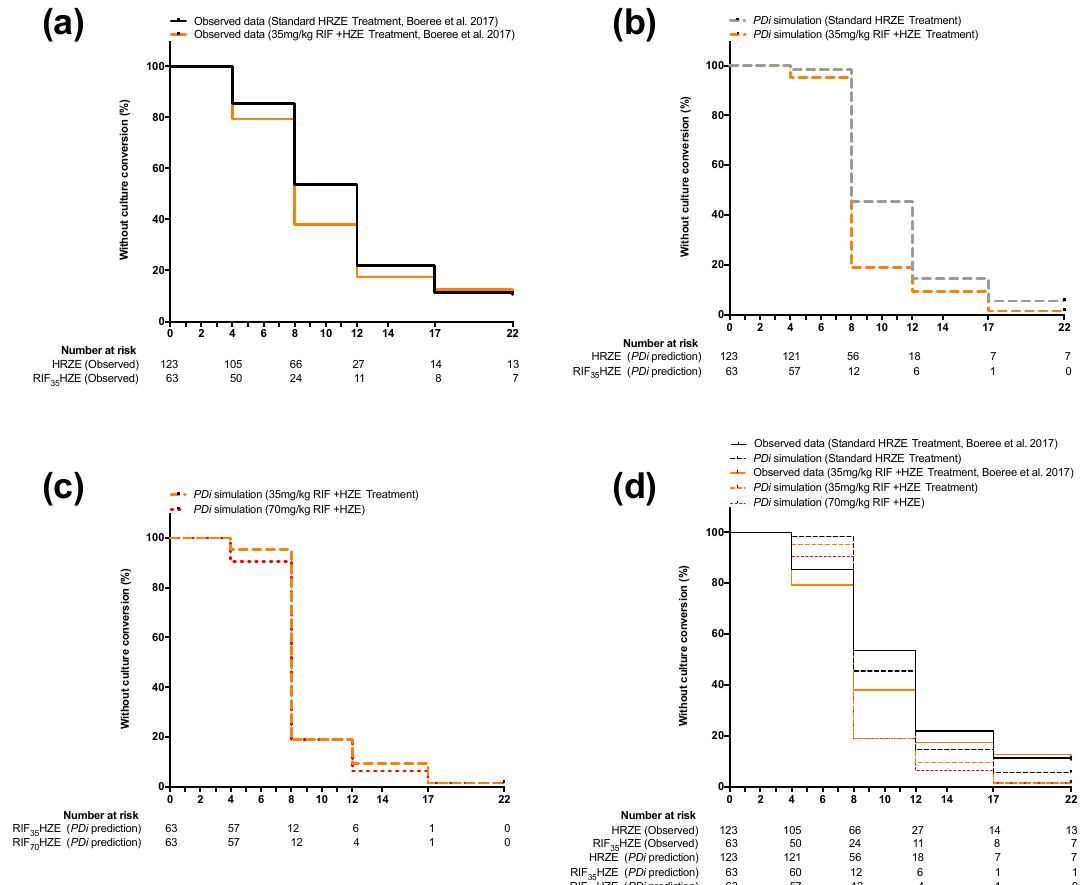
Figure 2. Simplified Kaplan–Myer curves comparing observed and predicted clinical outcomes (defined as conversion to culture negative status using MGIT over time) of the standard RIF dose-containing regimen (HRZE) versus the 35 mg / kg RIF dose-containing regimen (H 35 RZE): ( a ) reported data in Boeree et al. comparing HRZE (solid black line) and H 35 RZE (solid orange line); ( b ) mathematically predicted outcome (using PD i modelling) for HRZE (dashed black line) and H 35 RZE (dashed orange line) applying the same conditions, patient numbers and PK parameters reported in the Boeree et al. clinical trial; ( c ) mathematically generated comparison between H 35 RZE (orange dashed line) and a 70 mg / kg RIF dose-containing regimen (H 70 RZE) (red dotted line); ( d ) overlaid Kaplan–Myer curves seen in panels ( a ), ( b ) and ( c ).